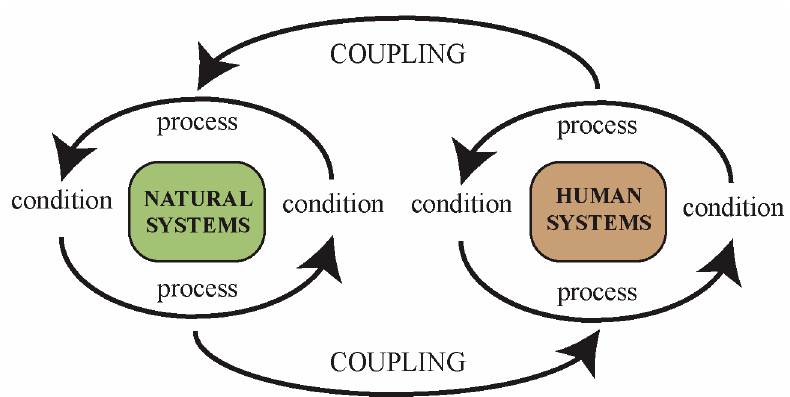
Figure 1. Traditional framework for coupled human and natural systems (CHANS) studies. Source: Figure adapted by the authors from National Science Foundation (NSF) 18-503 (2017: p. 4) (See: https://www.nsf.gov/pubs/2018/nsf18503/nsf18503.pdf)